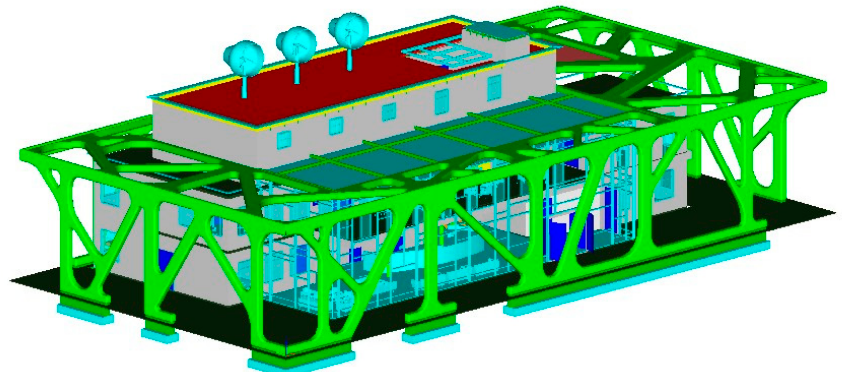
Figure 8. IFC test dataset [36] visualized using the FZK Viewer.